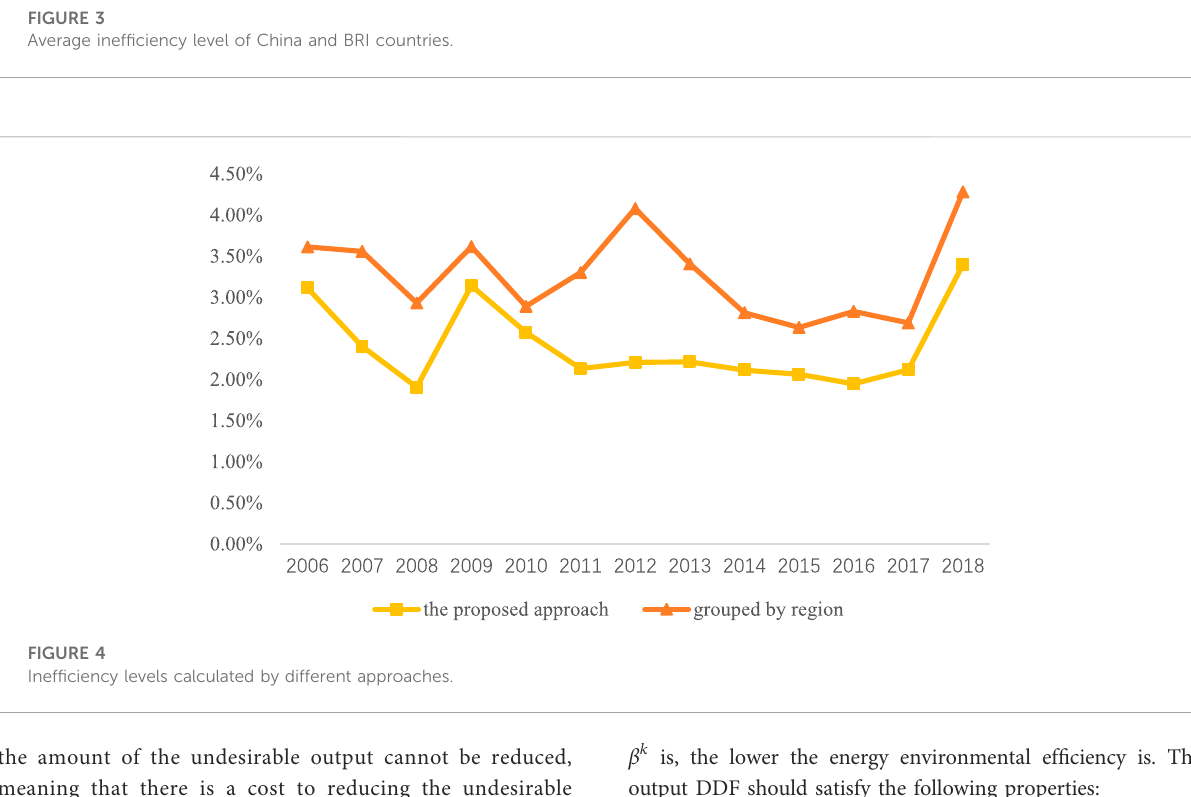
FIGURE 3 Average inef fi ciency level of China and BRI countries.